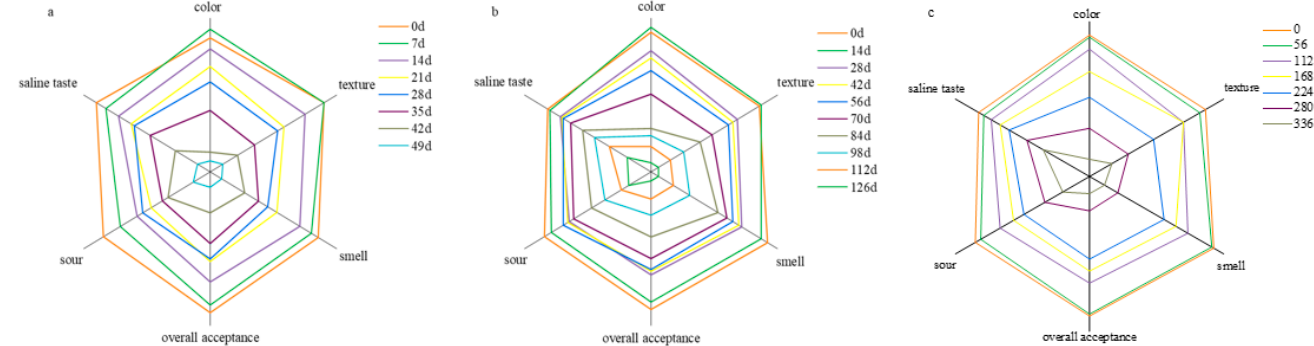
Figure 1. Sensory score obtained during storage at different times (the temperature of ( a ) is 45 °C; the temperature of ( b ) is 35 °C; the temperature of ( c ) is 25 °C).